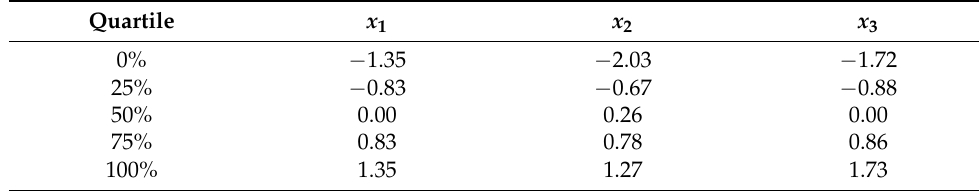
Table 2. The quartile values for ideal series.